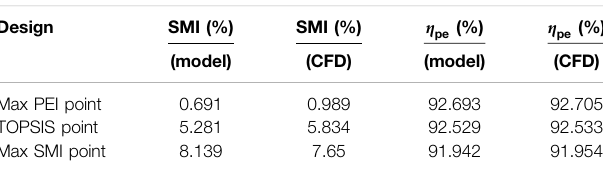
TABLE 3 | Ranges of casing groove